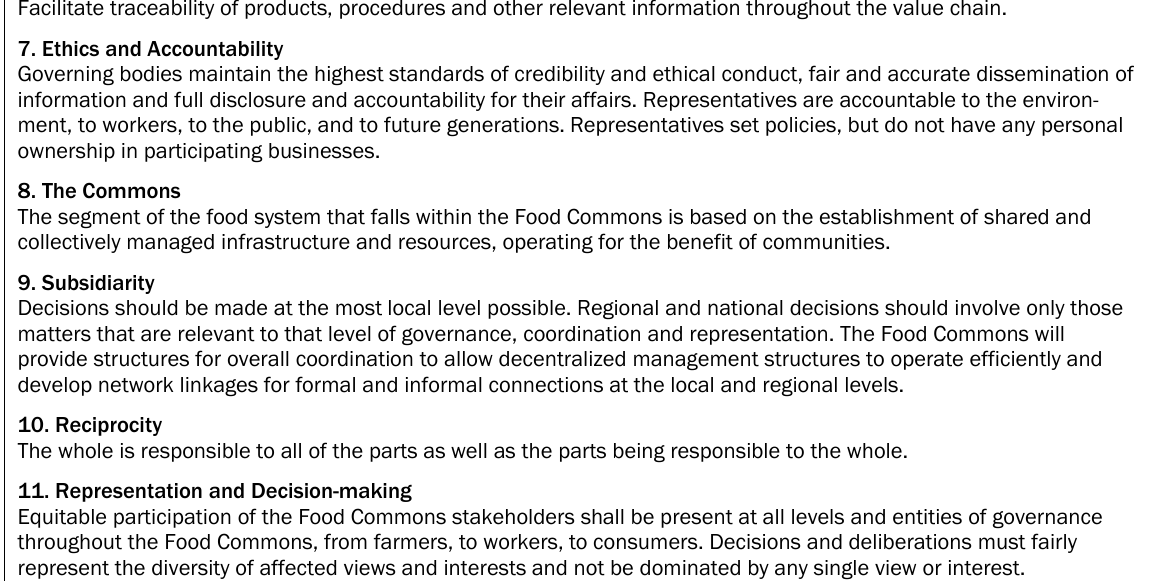
Figure 2. Principles for a Just and Sustainable Food Commons (The Food Commons,